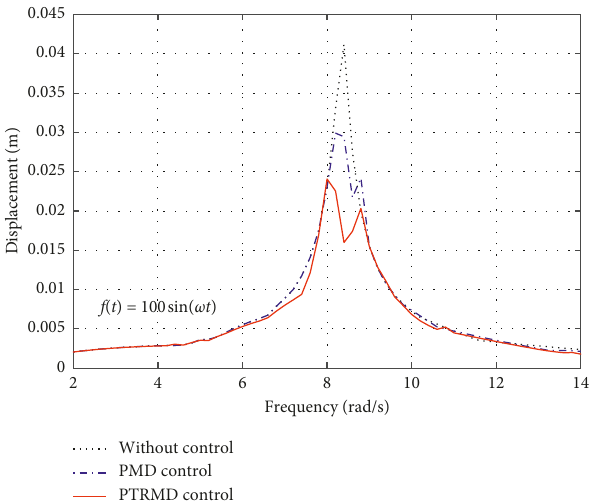
Figure 7: Comparison of the excitation frequency versus response amplitude